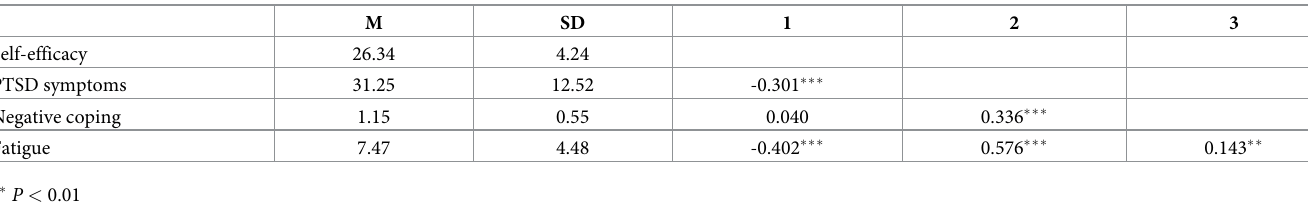
Table 2. Pearson’s correlation among self-efficacy, PTSD symptoms, negative coping and fatigue ( N = 527).